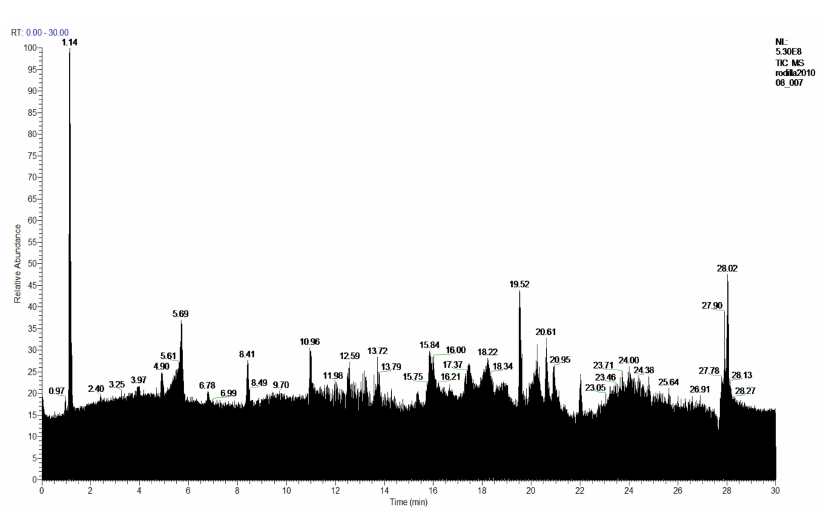
Figure 13. Chromatogram of 2-Ethanol extract from P. hypoleucinum